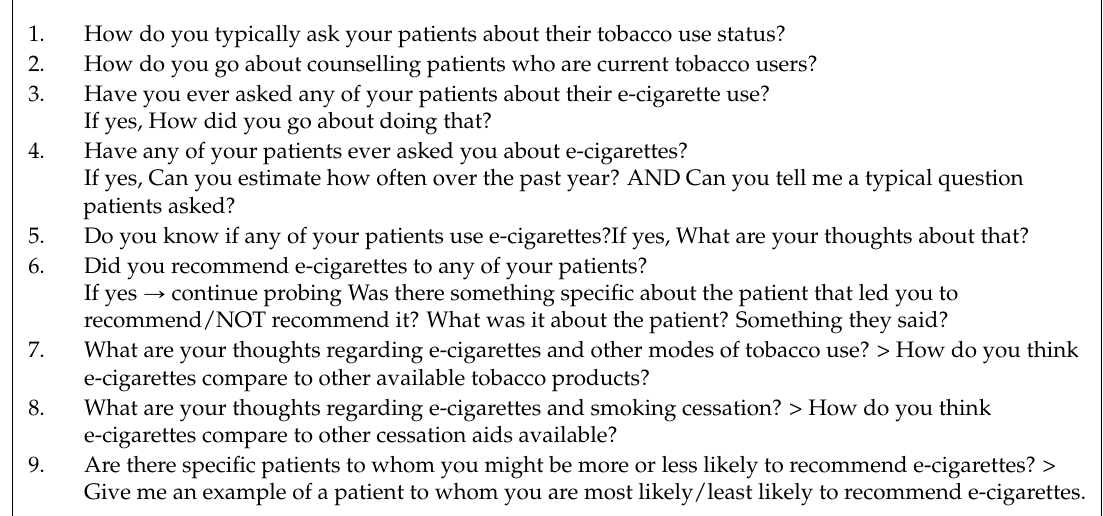
Table 1. Semi-structured interview questions with main probes